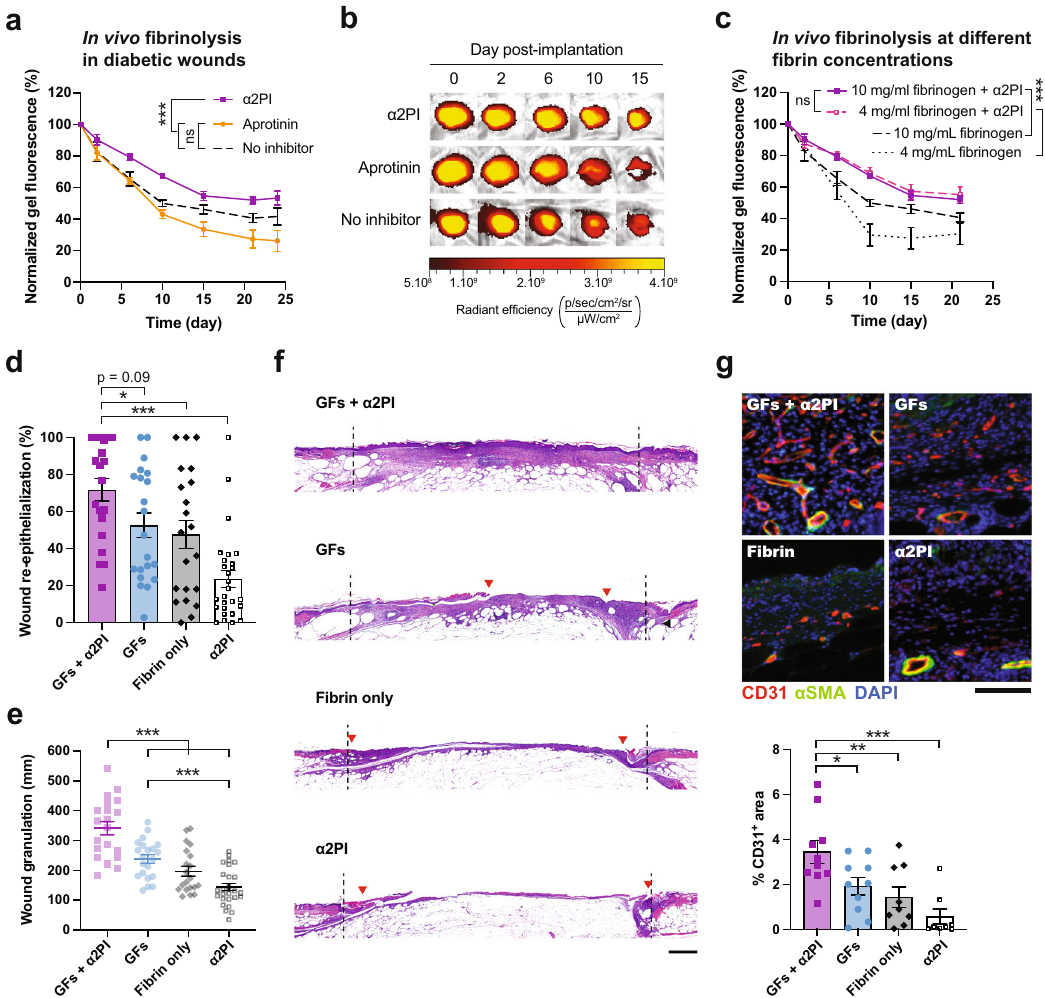
Fig. 3 α 2PI enhances fi brin-mediated delivery of engineered GFs and improves diabetic wound healing. In the wound healing experiments, 6 mm diameter wounds were surgically induced on the skin of the back of db/db mice and topically treated with fi brin gels once at day 0. As a GF treatment, 200 ng of VEGF-A-PlGF-2 123 – 144 + 200 ng of PDGF-BB-PlGF-2 123 – 144 were incorporated in the fi brin gels. a In vivo degradation of fi brin gels containing 15 μ M of α 2PI, aprotinin or no inhibitor upon topical application on diabetic wounds. Fibrin degradation was monitored via reduction in gel fl uorescence measured by IVIS imaging ( n = 6 gels/group). b Representative images of fi brin degradation on diabetic wounds, associated to a . c In vivo fi brinolysis with or without α 2PI for fi brin gels made of 4 mg/mL or 10 mg/mL fi brinogen ( n = 6 gels/group). d , e Quanti fi cation of diabetic wound closure d and granulation tissue e at day 10 upon topical application of fi brin gels containing engineered GFs and/or 3 μ M of α 2PI (n ≥ 20 wounds/group, pooled data from 2 independent experimental repeats). f Histological images of the wounds observed at day 10 upon different treatments with fi brin gels ± engineered GFs ± 3 μ M α 2PI. Images are representative of the wound granulation observed in the different groups (black dashed line = initial wound opening; red arrow = tip of the wound epithelial tongues; scale bar = 500 μ m). g Representative images and quanti fi cation of angiogenesis in the center of the wounds at day 10 post-wounding. Quanti fi cation of wound angiogenesis was determined by the area of CD31 + endothelial cells over the area of granulation tissue analyzed by immunohistochemistry ( n ≥ 8 wounds/group; scale bar = 100 μ m). Mean ± SEM. Statistical comparisons were done using ANOVA test with Dunnett ’ s post-hoc test in a , c , e , g , and using Kruskal-Wallis test with Dunn ’ s post-hoc test in d : * p -value < 0.05, ** p -value < 0.01, *** p -value < 0.001, ns non-signi fi signi fi cantly faster (Fig. 3c). This result, expected based on the ones obtained in the subcutaneous model, highlighted that α 2PI permits adequate protection of low-concentration fi brin bioma- terials for topical application of fi brin on wounds as well.